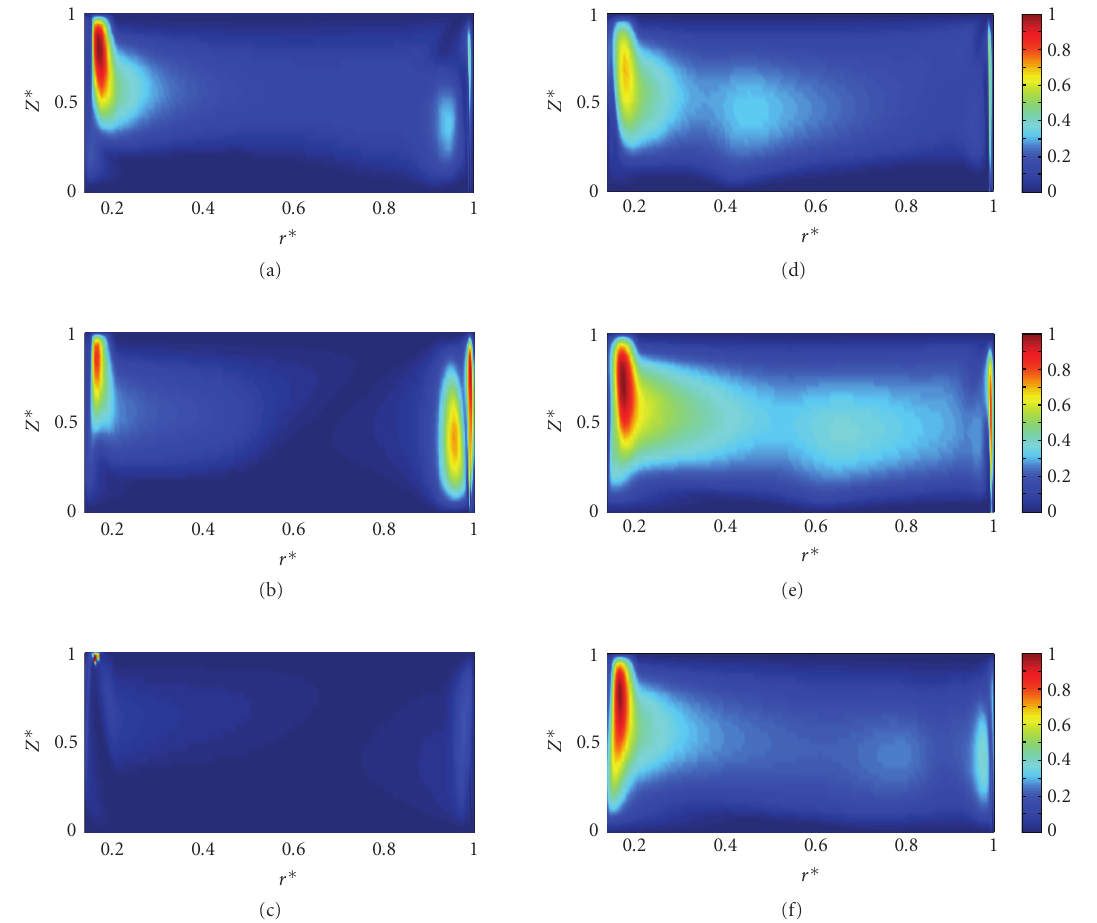
= 675 . 94; (b) (1 . 8 × 10 5 , 5000), Re max = 1615 . 7; (f) (10 6 , 10000), Re t max